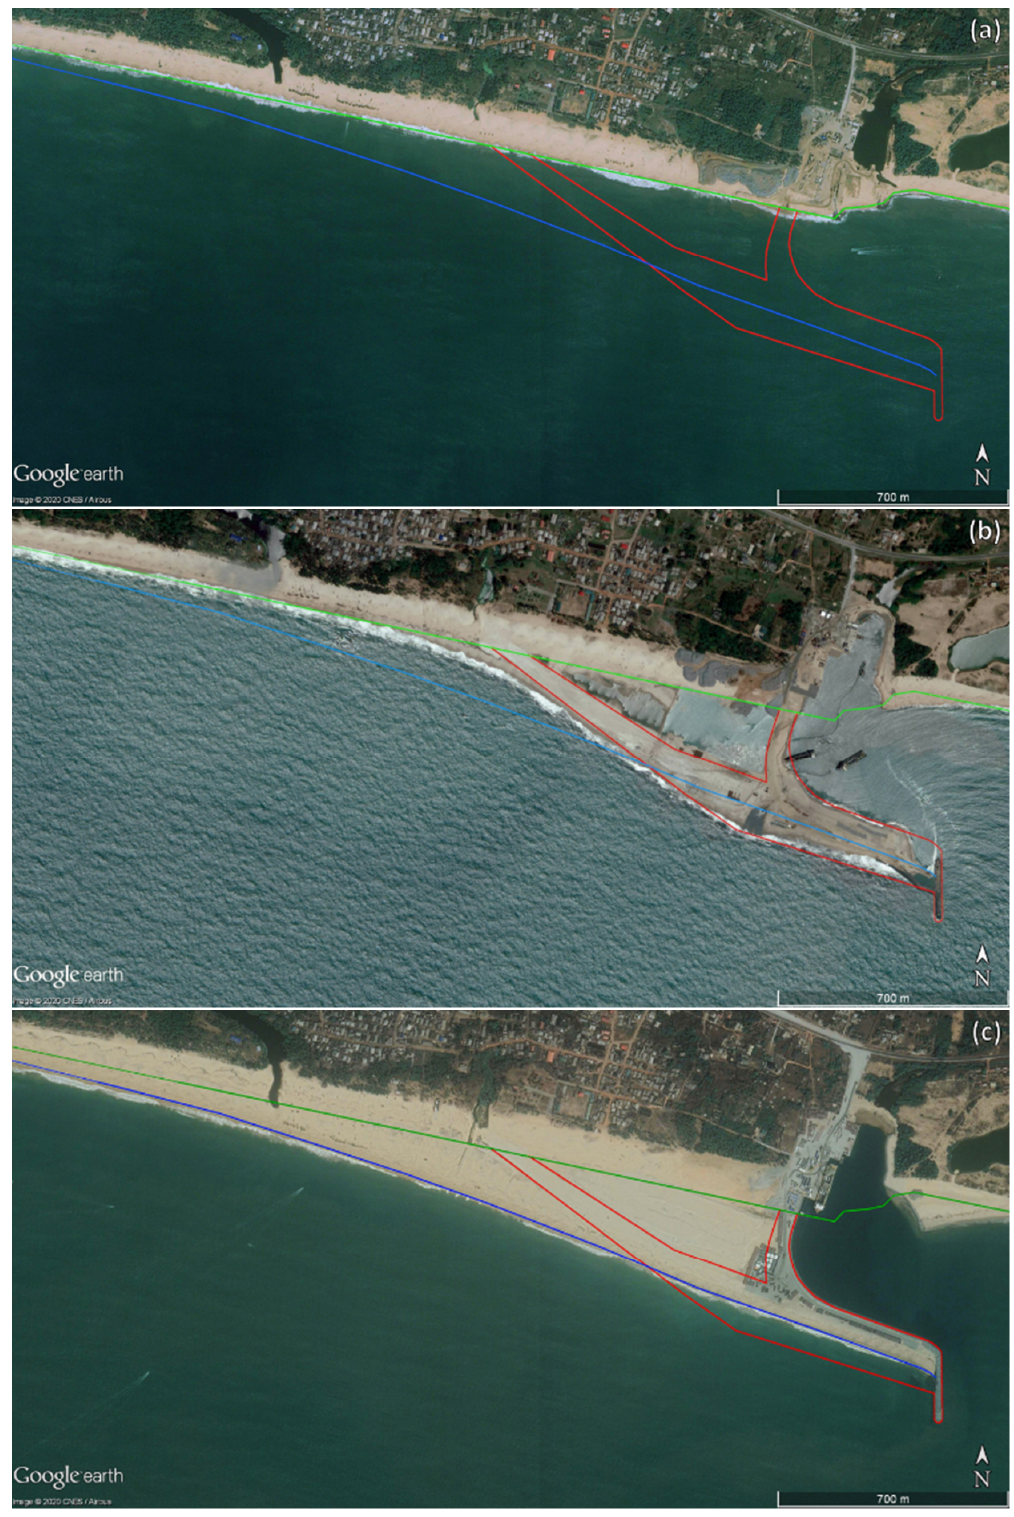
Figure 8. ( a ): Satellite image from 25 December 2017 from [15], showing the coastline just before construction (green line). ( b ) Satellite image from 06 March 2018 from [15], showing the situation just after the sandbar body has been put in place according to the design (red line), ( c ) satellite image from 24 December 2018 from [15], showing the resulting reshaping after a wet season and the coastline reaching the equilibrium coastline orientation as expected (blue line).